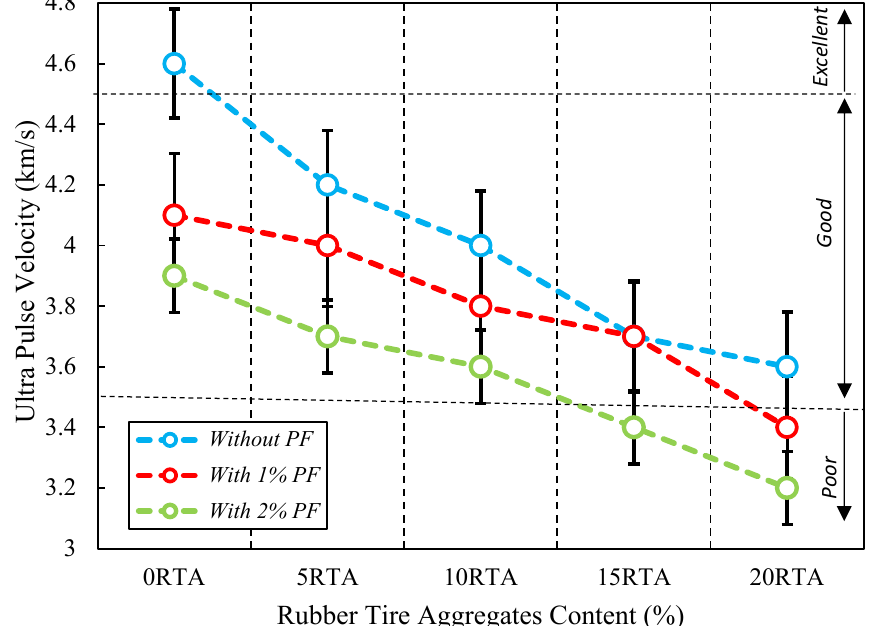
Figure 16. Effect of PF and RTA on the ultrasonic pulse velocity.